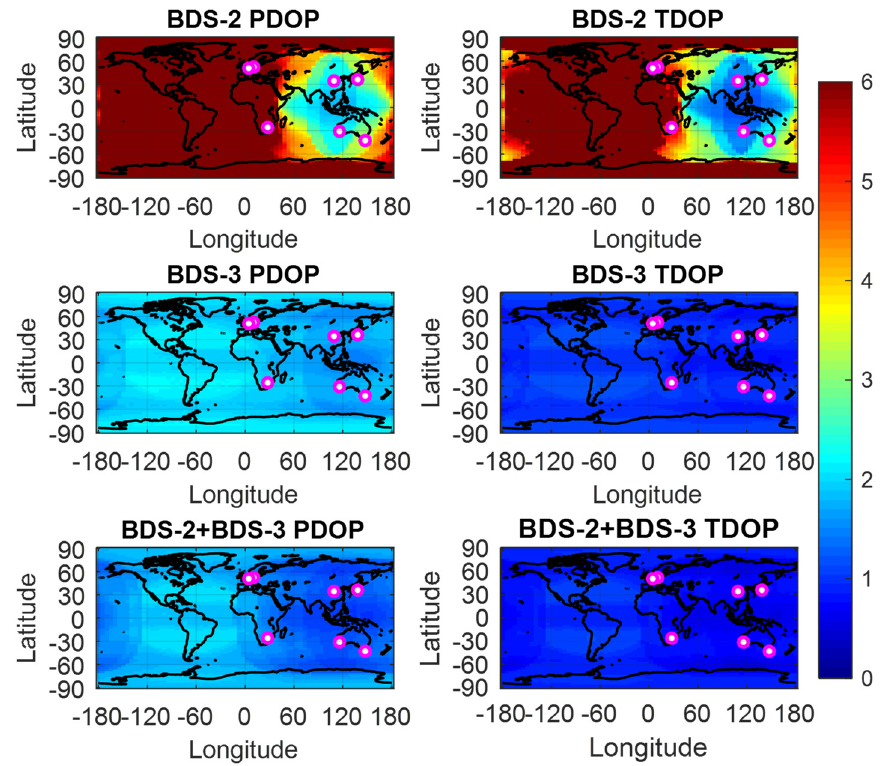
Figure 2. Global distribution of precision dilution of precision (PDOP) and time dilution of precision (TDOP) for BDS-2-only, BDS-3-only, and BeiDou global navigation satellite system (BDS) (BDS-2/BDS-3). The selected stations are also marked. Table 2. The properties of the selected stations.